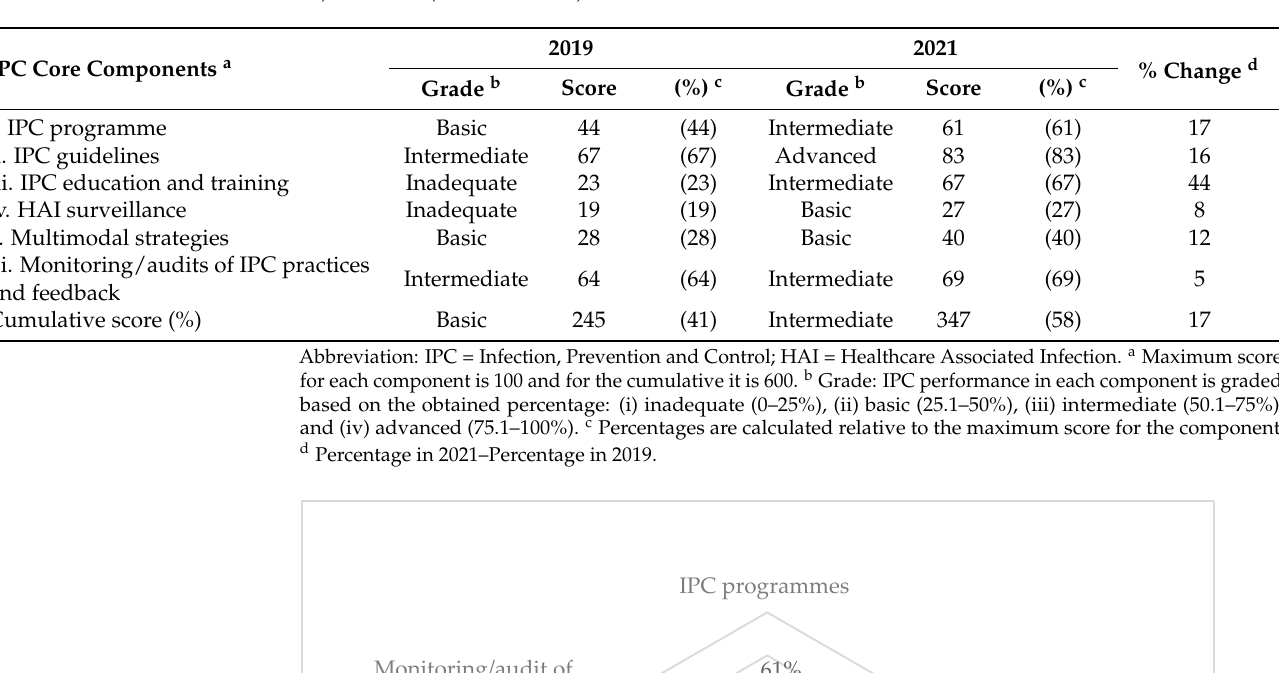
Table 1. Percentage change in minimum IPC score at the national IPC unit between 2019 (pre- COVID-19) and 2021 (COVID-19 era) in Sierra Leone.